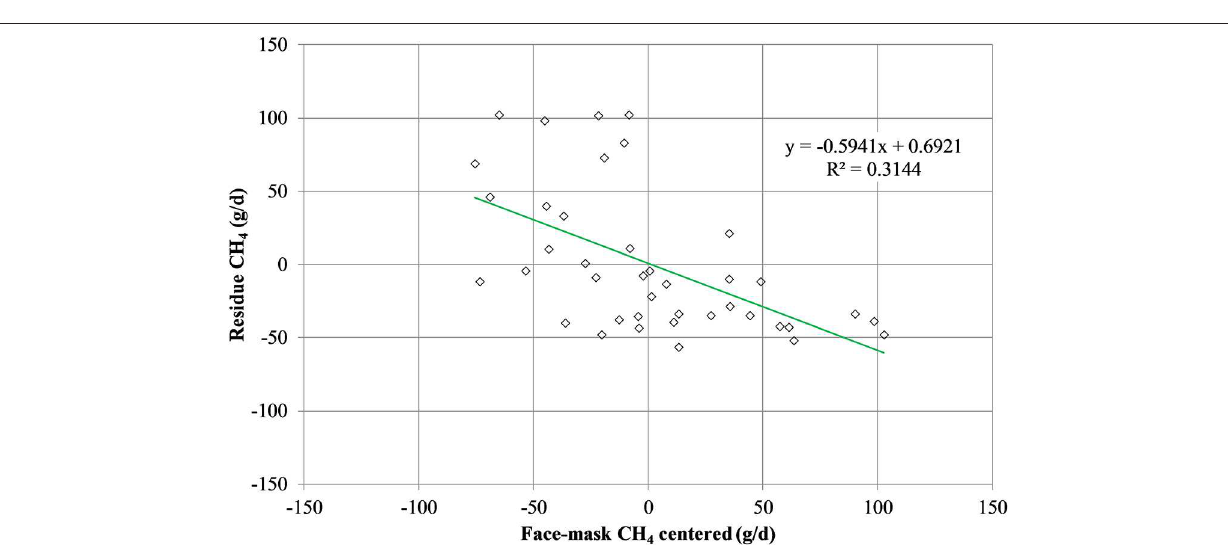
FIGURE 3 | Plot of residue (respiration chamber minus face-mask) CH 4 production (g/d) vs. centered (LSMEANS minus averaged of face-mask measurement) CH 4 production as measured by the face mask. Absence of bias occurred when intercept is equal to